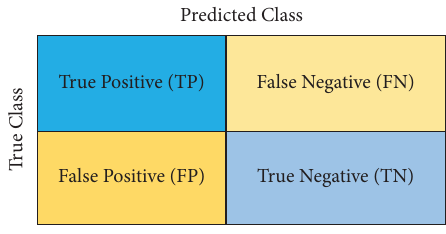
Figure 9: Confusion